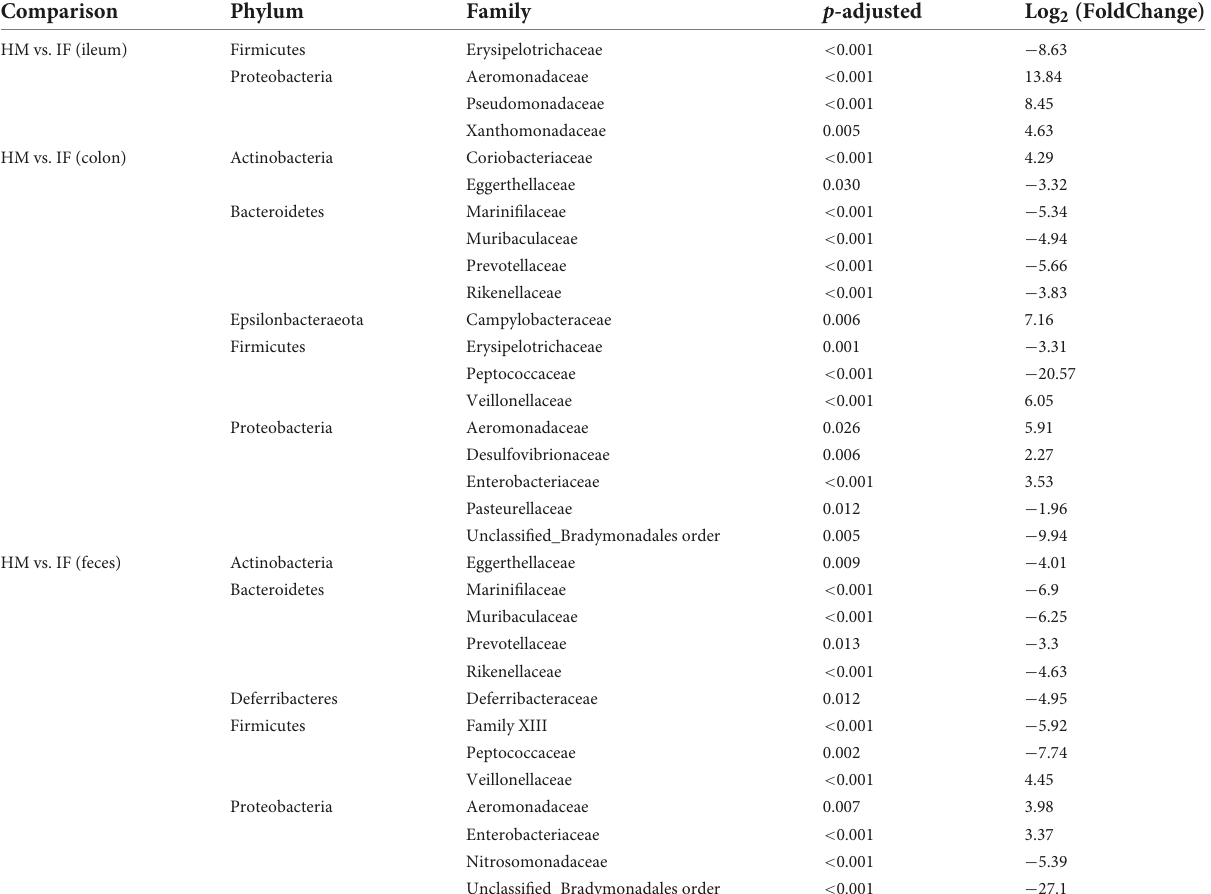
TABLE 2.2 Dietary impact on relative abundance of bacterial families in ileum, colon and feces of HM- and IF-fed piglets.